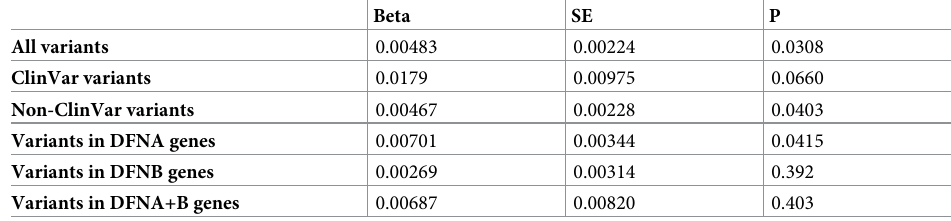
Table 1. Association of total burden in known hearing loss genes in PMBB with degree HL.